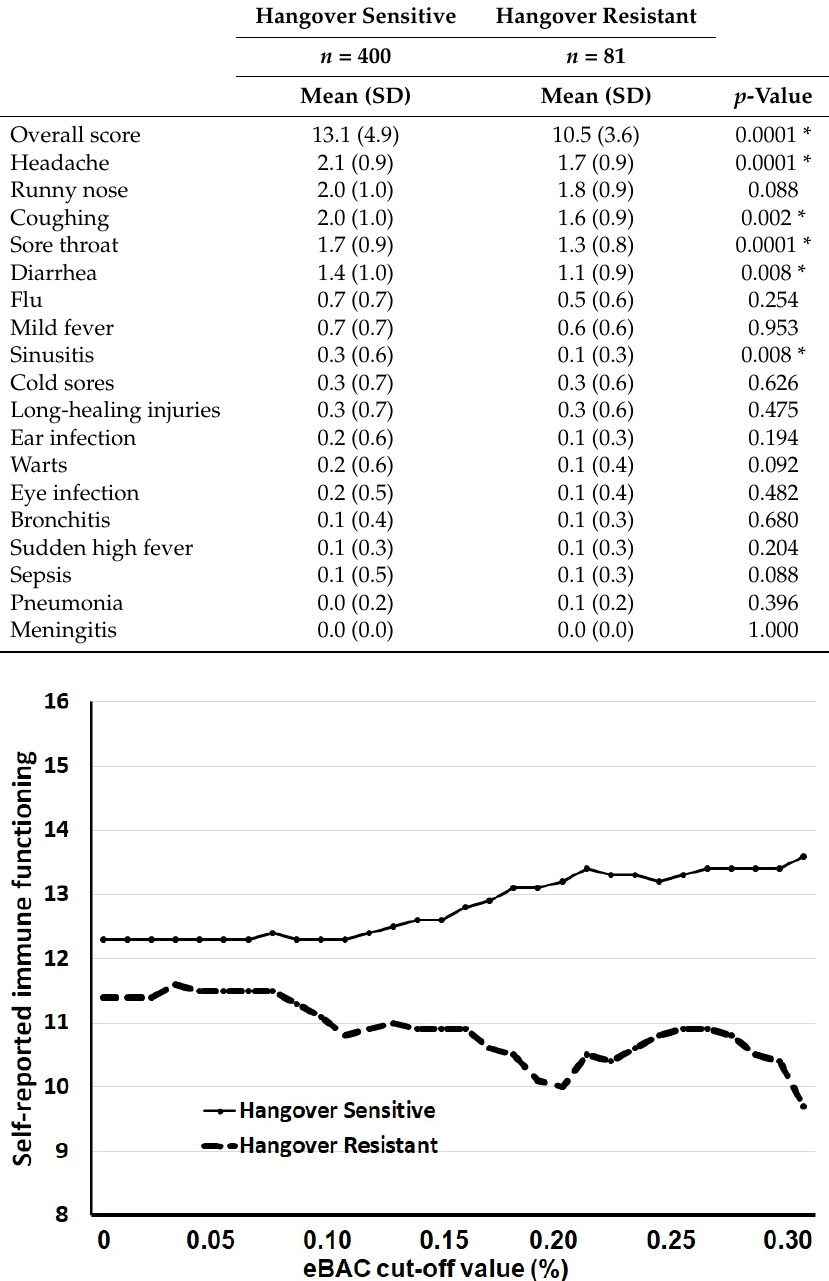
Figure 2. Immune function across eBAC cut-off levels. Abbreviations: eBAC = estimated blood alcohol concentration. For each eBAC cut-off level, participants were allocated to either the hangover-sensitive or hangover-resistant group, and their overall self-reported immune function score was computed.